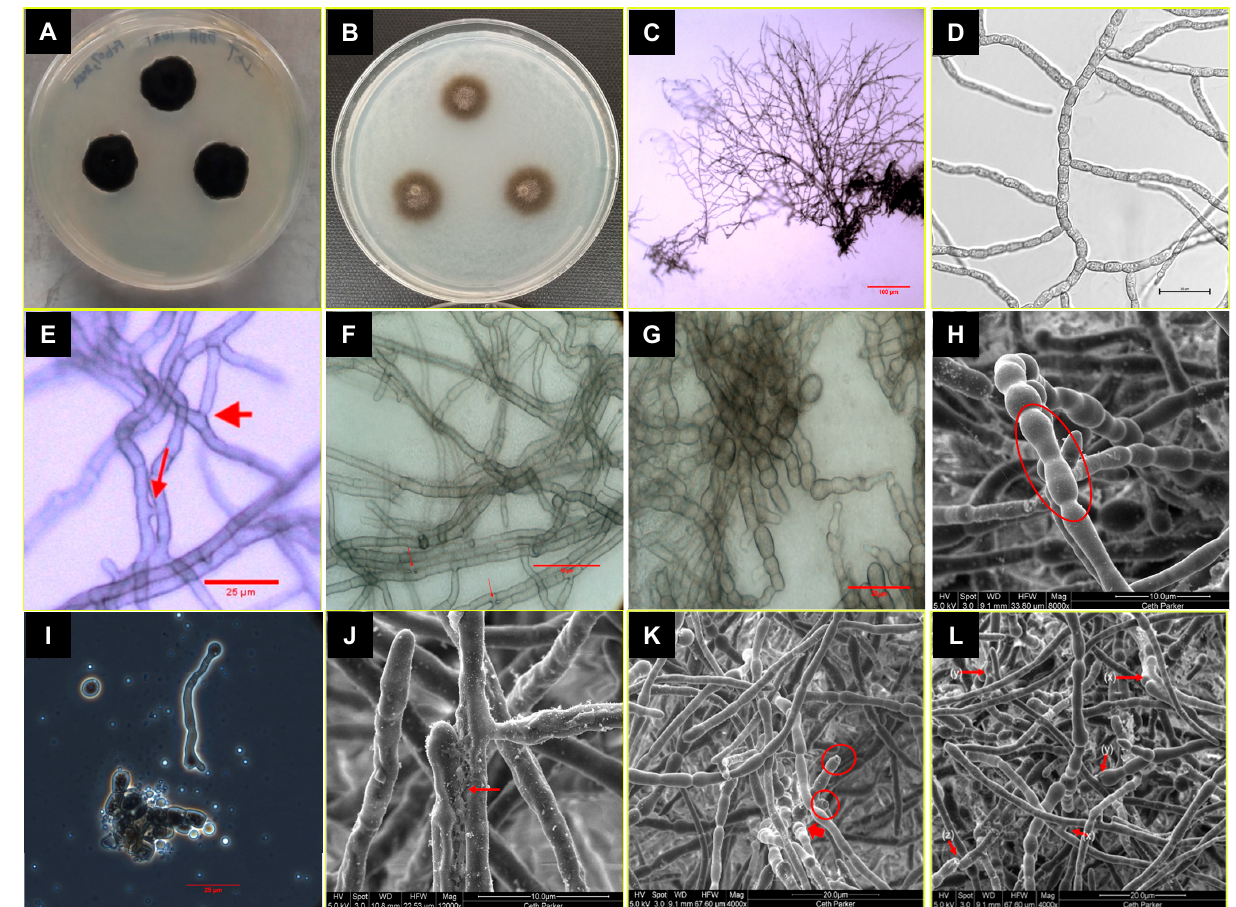
Figure 4. Colony and cell morphology of P. melaninifex . Colony morphology on day 21 of incubation at room temperature (25 ◦ C) on ( A ) PDA medium and ( B ) OMA medium. ( C ): Blastic proliferation of hyphae. ( D ): Arthroconidia form readily and branch at roughly uniform angles. ( E , F ): Hyphael anastomosis in young vegetative hyphae. ( G ): Mature hyphae. ( H ): Arthroconidia and dumbbell- shaped hyphae. ( I ): Conidia on the top left corner; germinated conidia with long tube formation in the center of the image and a clump of arthroconidia in the lower center of the image, image is taken at 100x. ( J ): Hyphael anastomosis. ( K ): Arthroconidia radiating out from the arthroconidial node (arrow), arthroconidial blunt ends are encircled. ( L ): L (x) and L (y) shows hyphael anastomosis; L (z) represents arthroconidial